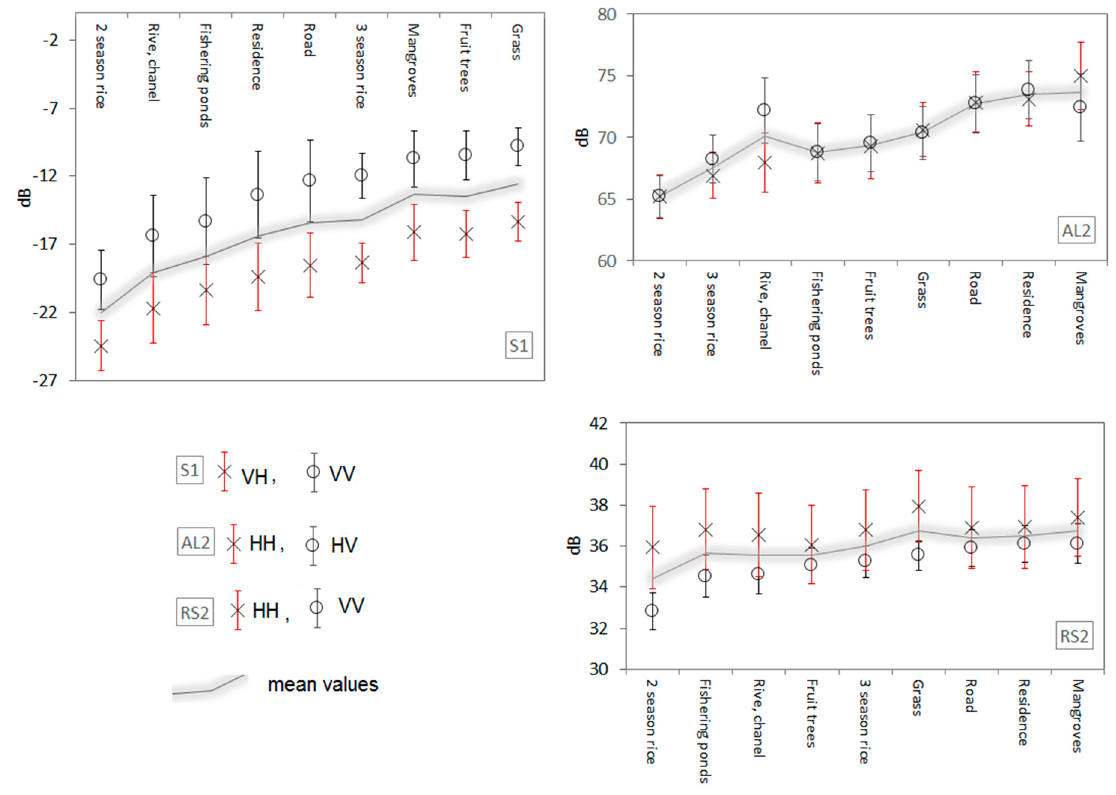
Figure 10. Comparison effects of polarizations on mean dB values of each LULC class (the glowing lines represent the mean values of corresponding pair polarizations).